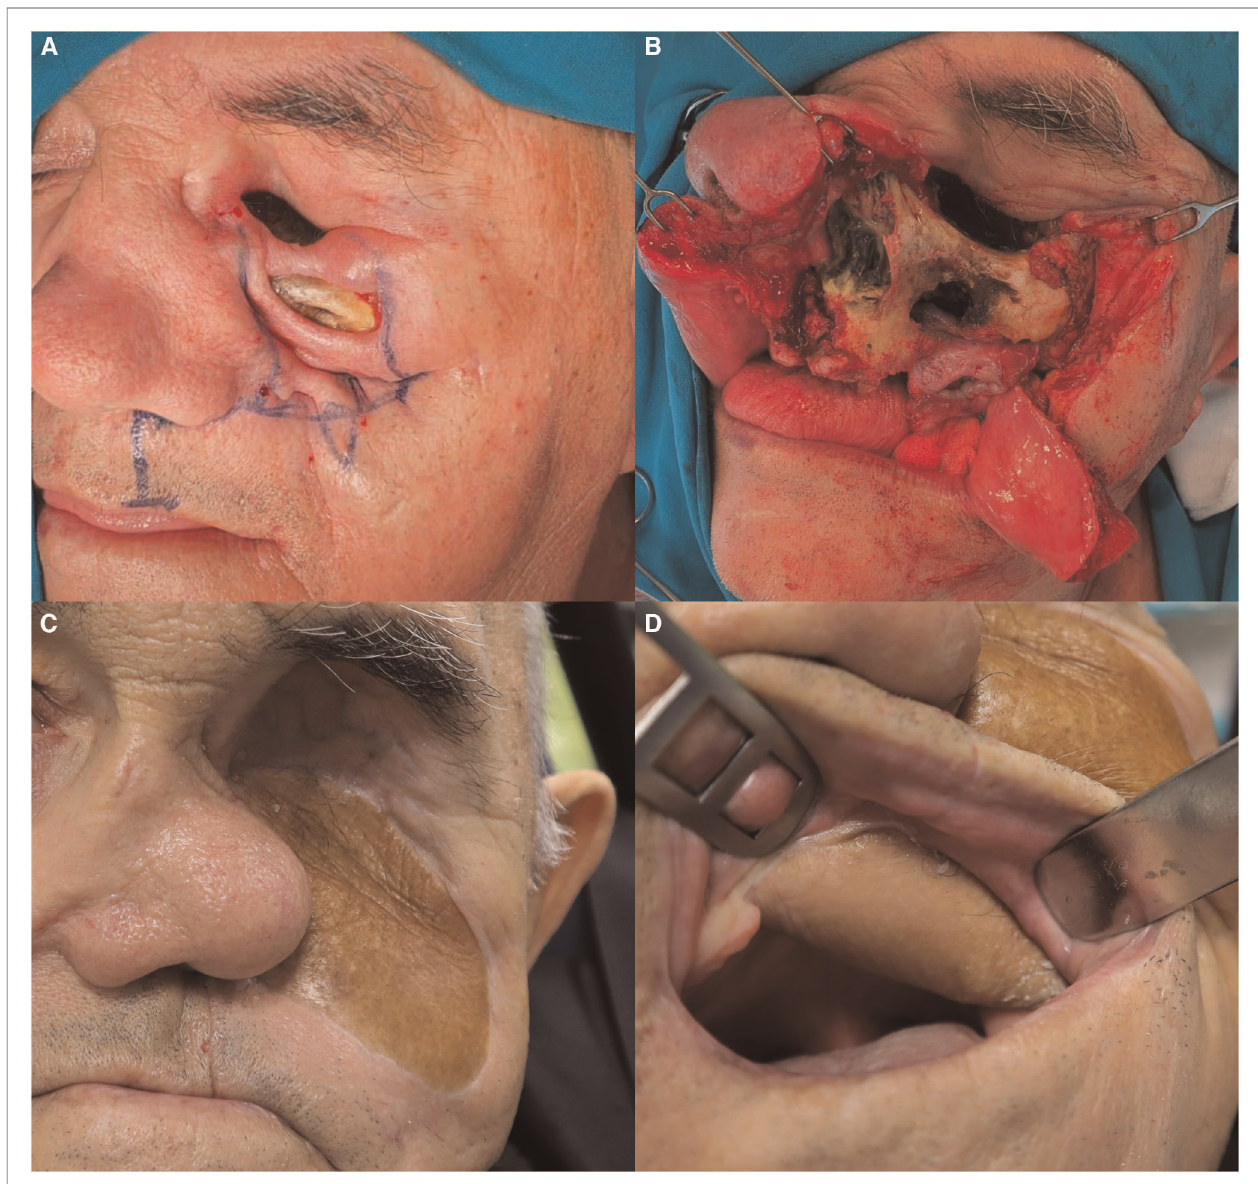
FIGURE 4 | Reconstruction of the defect. ( A ) Preoperative planning with modi fi ed Weber – Ferguson incision. ( B ) Exposed necrotic bone. ( C ) 9-month follow-up. The orbital and facial defect is closed, and maxillary dead space is obliterated with the bulk of the ALT fl ap. The nasal pyramid is leaning toward the operated side because the bone and cartilage support has been removed. ( D ) ALT fl ap lining the palatal